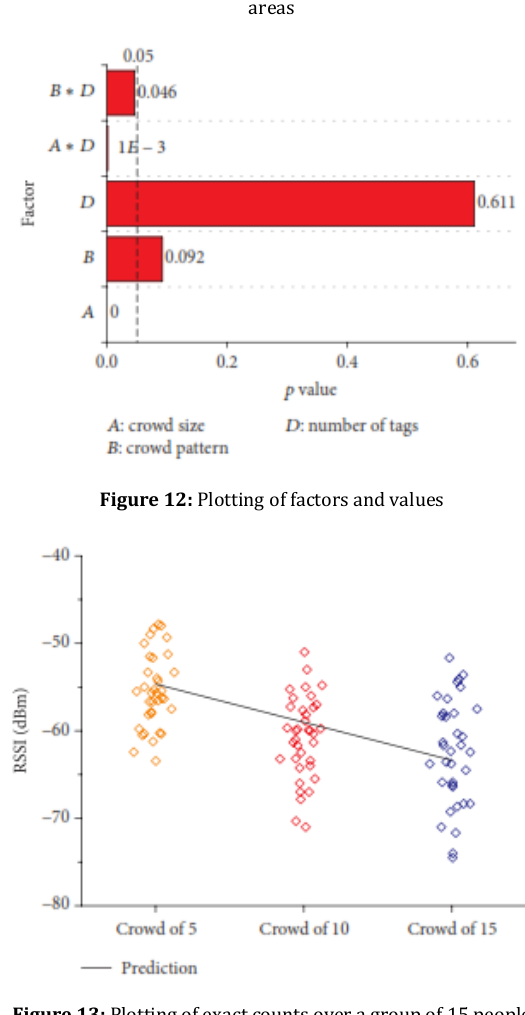
Figure 13: Plotting of exact counts over a group of 15